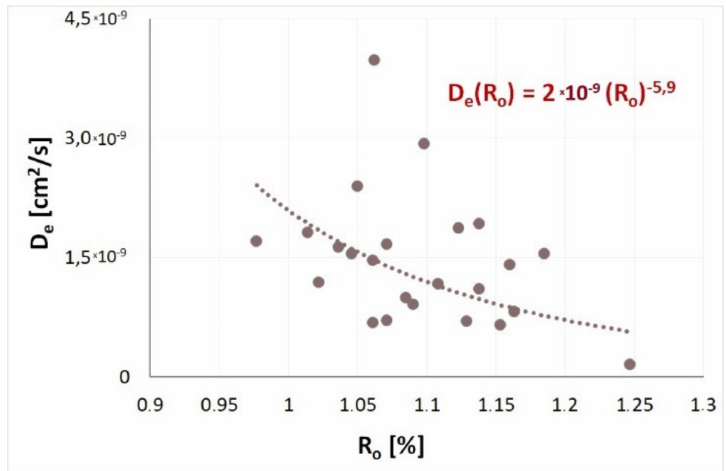
Figure 10. Influence of the degree of coalification on the effective diffusion